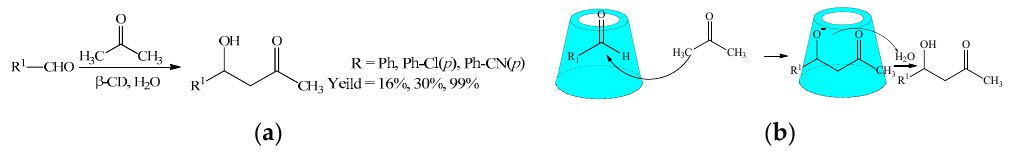
Scheme 26. ( a ) The asymmetric aldol reaction of aldehydes and acetone catalyzed by β -CD; ( b )